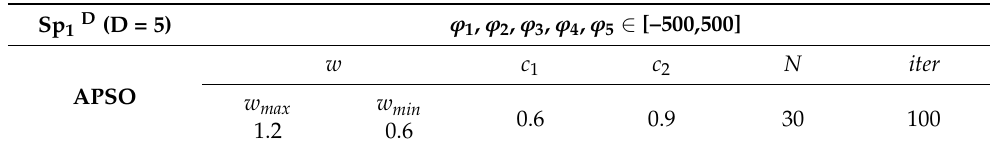
Table 2. Table 2. First particle search range of transmission system. Sp 1 D (D = 5)